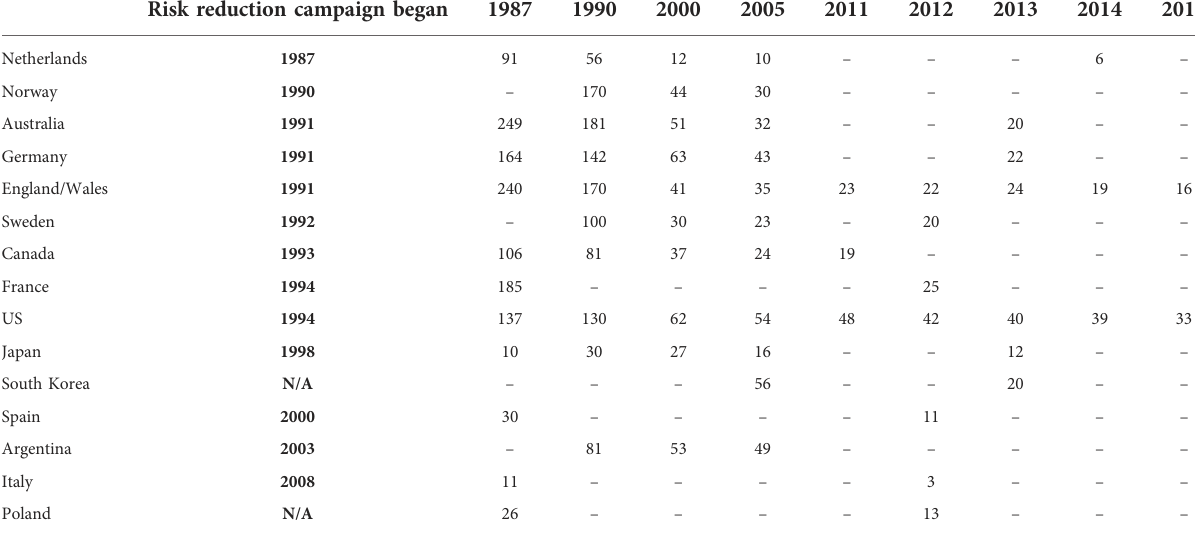
TABLE 2 Mortality rates due SIDS (deaths/100,000 births) by